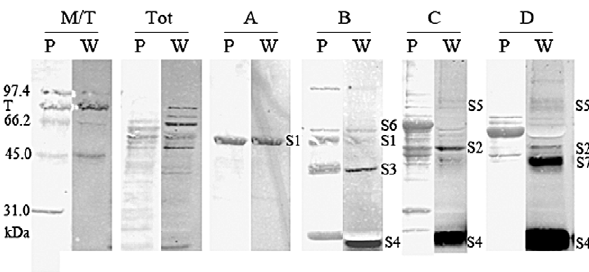
Figure 7. SDS-PAGE analysis of anion exchange chromatogra- phy fractions that contain the most DIG-reactive GPs. The fractions were screened by Dot-blot and SDS-PAGE by DIG labelling and anti-DIG Western blotting, and the fractions A, B, C and D shown here contain the most DIG-reactive GPs. Tot: total soluble proteins before ion exchange chromatography. M: Molecular weight marker. T: transferrin. P: Ponceau red staining of total proteins. W: anti-DIG Western blot. S1 to S4 correspond to the GPs detected on Figure 4A, while S5 to S7 correspond to GPs that are only detectable in WT after enrichment of the samples by ion exchange chromatography. However, these GPs were detectable in the total soluble fraction of the flaA1 and hp0366 mutants.